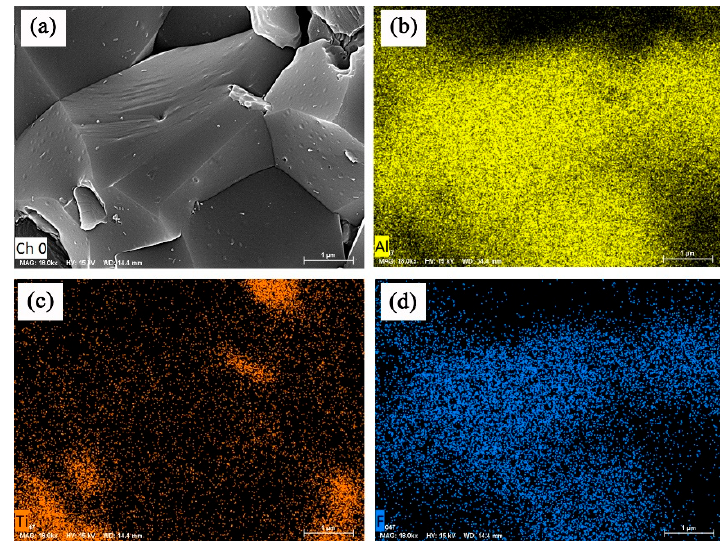
Figure 5. SEM micrograph and EDS spectra of fracture surfaces of Al 2 O 3 / TiC / CaF 2 self-lubricating ceramic composites: ( a ) fracture morphology of Al 2 O 3 / TiC / CaF 2 ceramic composites ( b ) Al element ( c ) Ti element ( d ) F element.